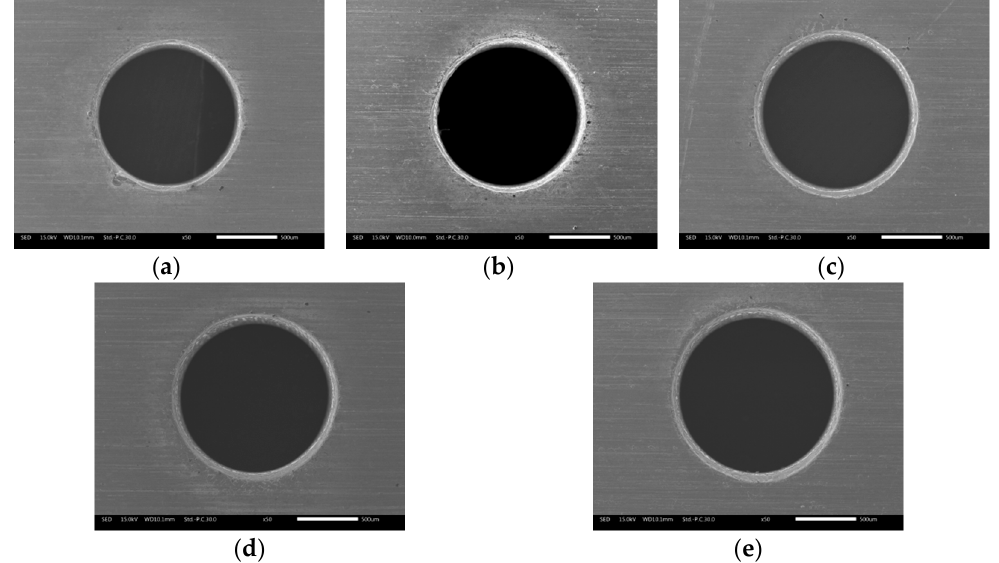
Figure 16. Exit morphology of holes after electrochemical reaming at di ff erent working fluid concentrations: ( a ) 2 g / L; ( b ) 4 g / L; ( c ) 6 g / L; ( d ) 8 g / L; ( e ) 10 g /